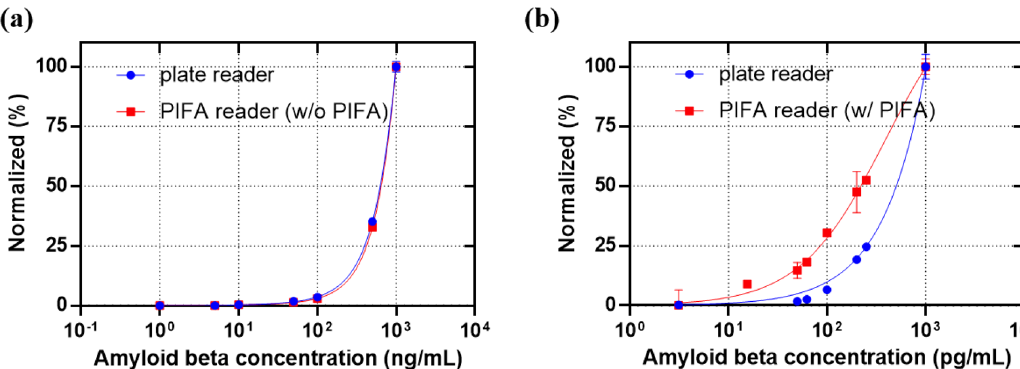
Figure 6. Normalized measurement of PIFA assay and plate reader with the commercial ELISA kit when concentration of amyloid beta was changed: ( a ) the normalized fluorescence intensity of resorufin measured by plate reader and PIFA reader with no photooxidation ( b ) the normalized measurement value of plate reader fluorescence and PIFA